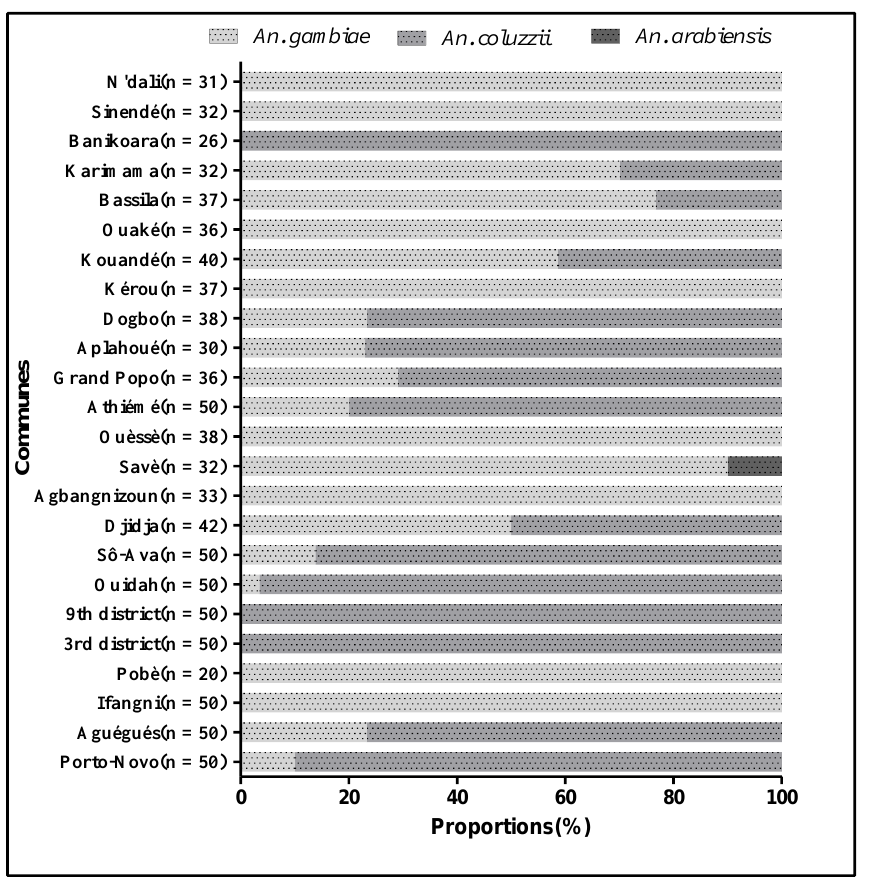
Figure 2. Proportion of the species of the An. gambiae complex in each